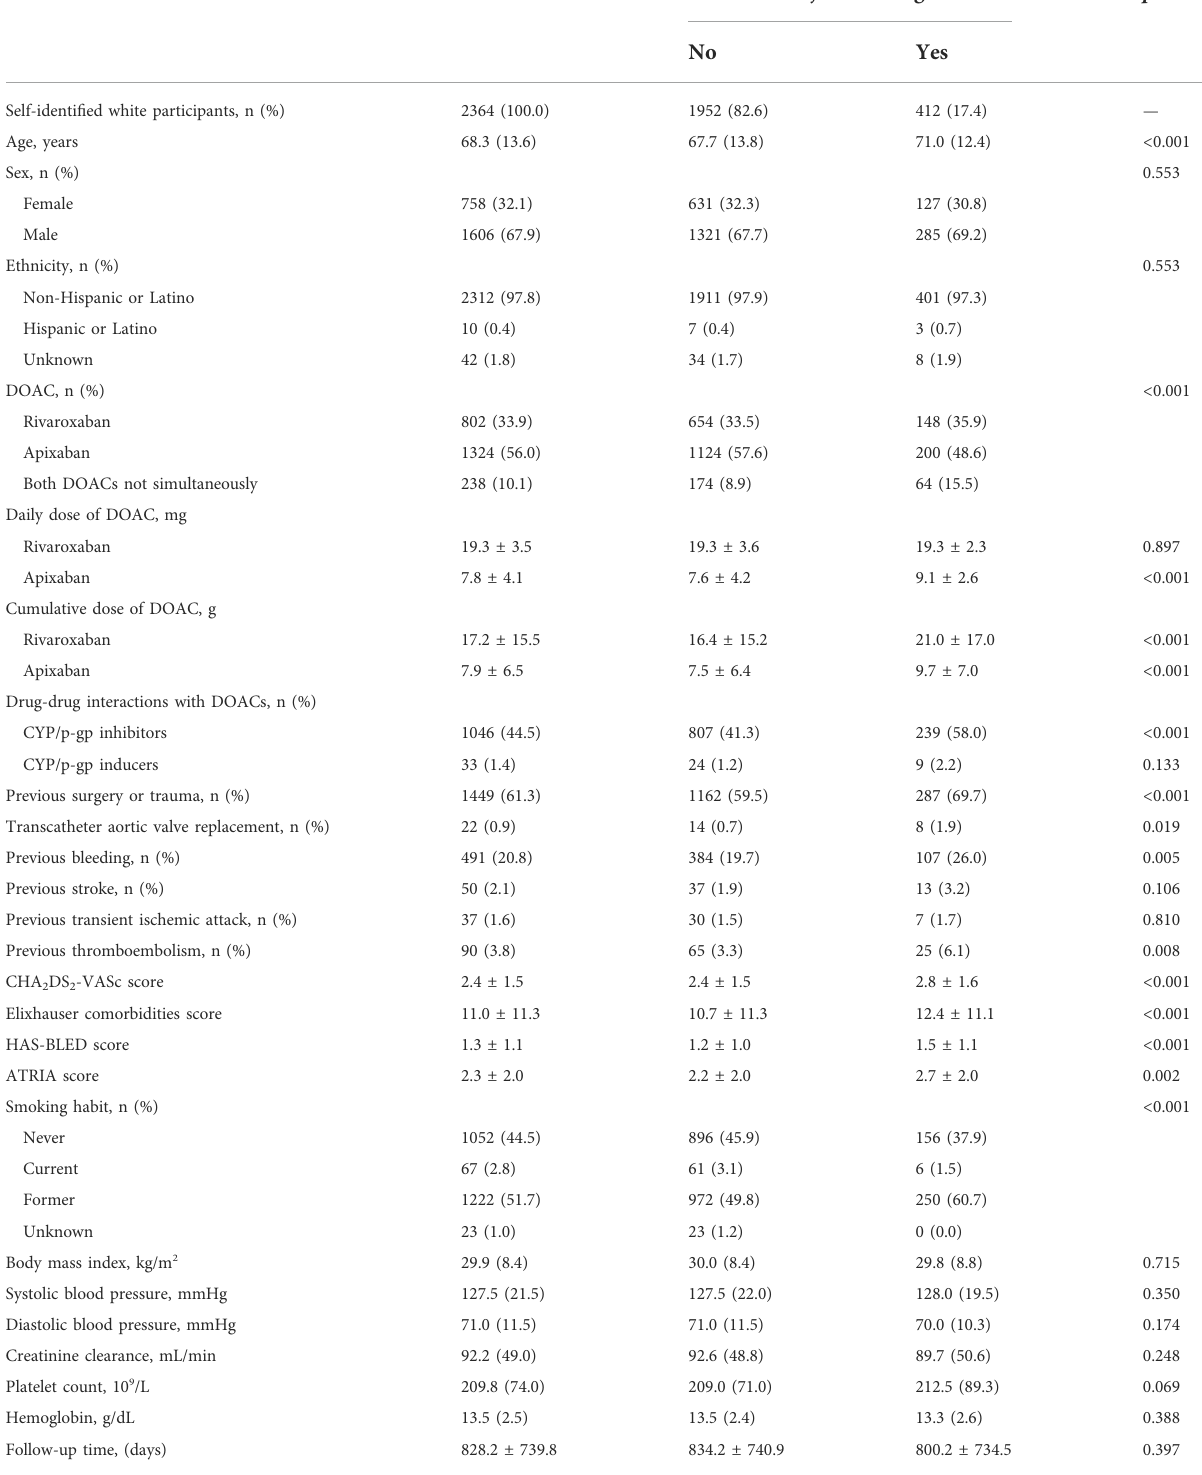
TABLE 1 Clinical and biochemical baseline characteristics of participants.